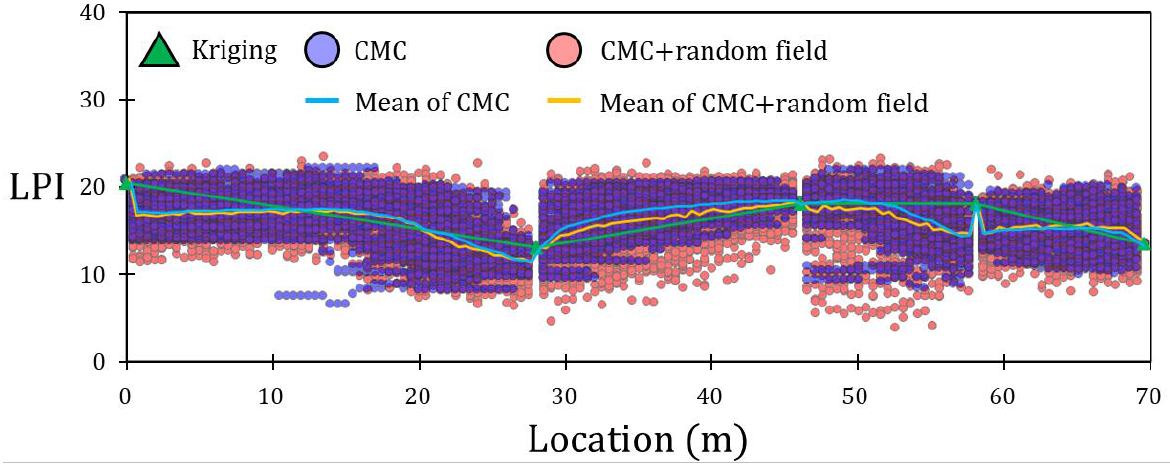
Figure 11. Comparison of the liquefaction-potential-evaluation results of three models through the JRA method.